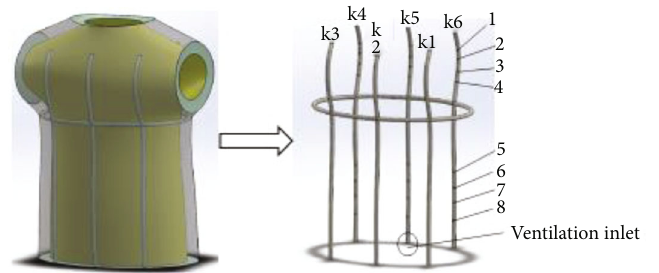
Figure 3: Longitudinal type.